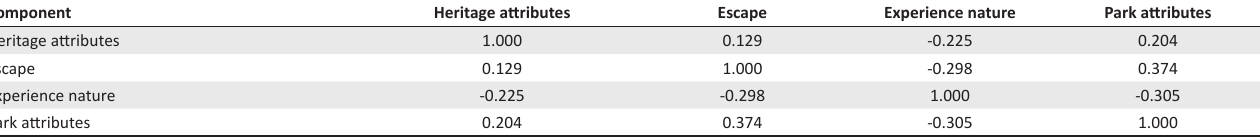
TABLE 4: Component correlation